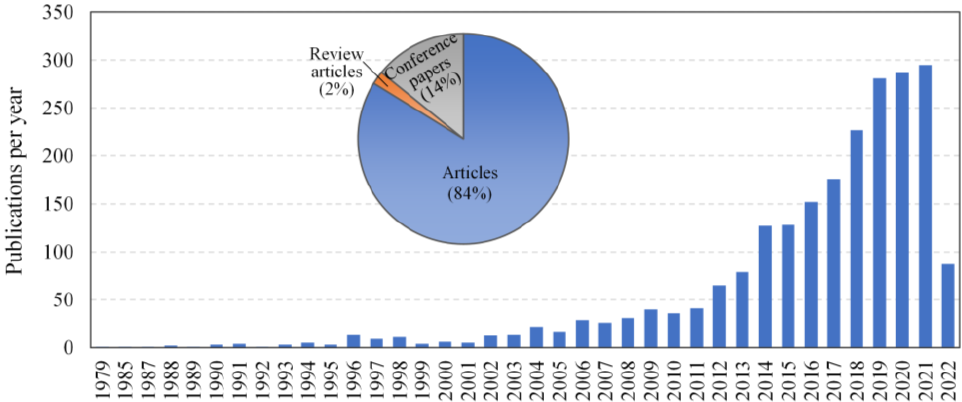
Figure 1. Statistics of ensemble literature in the refined areas.